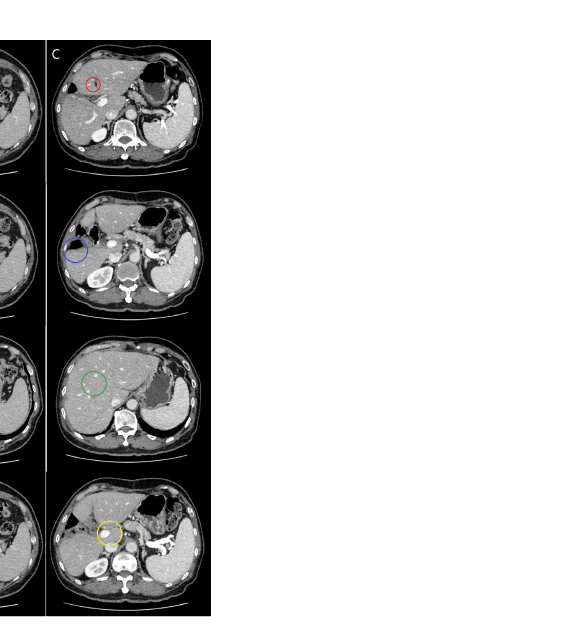
FIGURE 1 | The evaluation of tumor response during the clinical course. (A) Pretreatment computed tomography (CT) revealed recurrent lesions in the segment IV (red circle), V (blue circle) and IV/VIII (green circle) of the liver, and a metastatic lesion in the hepatic hilum with tumor thrombus in the main portal vein (yellow circle). (B) After two courses of combination therapy, CT showed the intrahepatic lesions decreased in size, and both the lesion in the hepatic hilum and the main portal vein tumor thrombus disappeared. (C) After six courses of combination therapy, CT showed complete resolution of all the